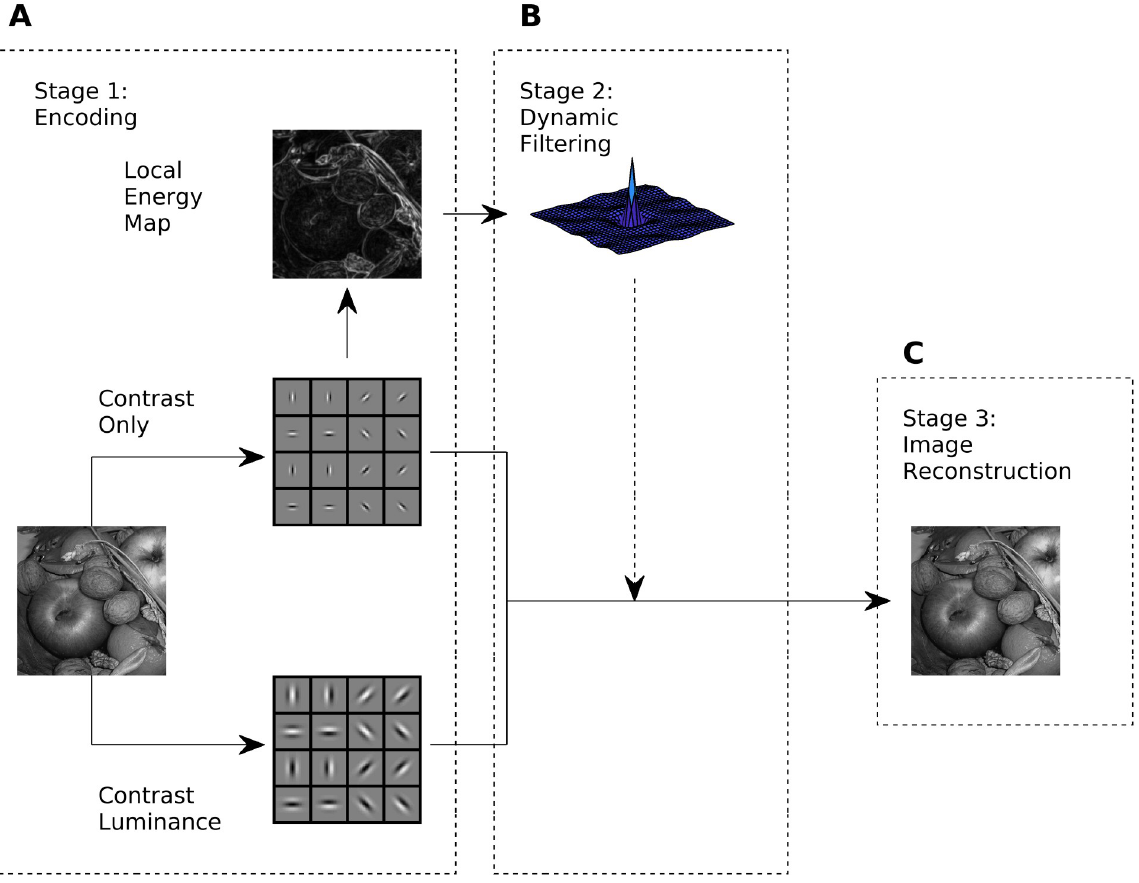
Fig 2. Model overview. Each of the three stages is mathematically specified in the Methods Section. (A) Stage 1: The Contrast-only channel and Contrast-Luminance channel are instantiated by filtering an input image with a corresponding set of Gabor filters with high spatial resolution (0.25 cycles per pixel) and coarse resolution (0.125 cycles per pixels), respectively. The local energy map is computed from the Contrast-only channel. (B) Stage 2: The kernel of the dynamic filter is estimated from the local energy map. Dynamic filtering equalizes the amplitude spectrum of the energy map, reducing redundancy. The decorrelated energy map serves as gain control for both contrast channels. (C) Stage 3: The output of the model is a brightness map that is obtained by solving an inverse problem, that is recovering the image from both contrast channels. Note that the two contrast channels do not interact with each other before Stage